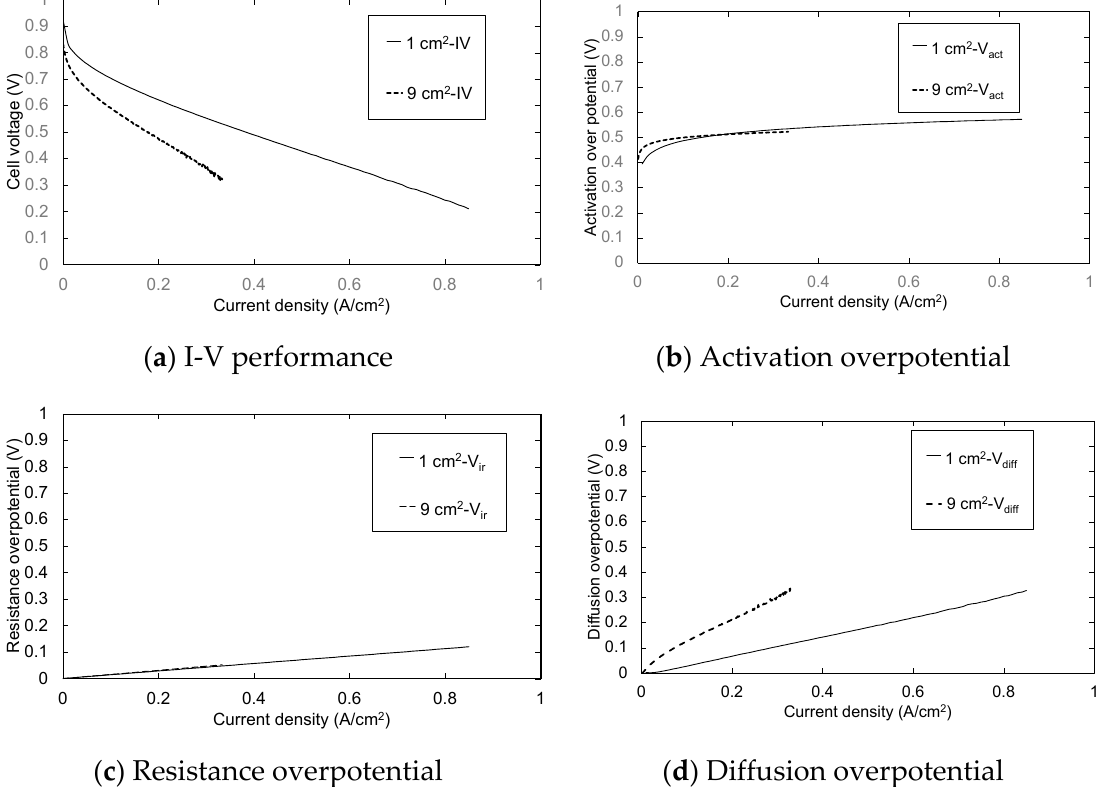
Figure 9. Influence of the electrode area on ( a ) I-V performance, ( b ) activation overpotential, ( c ) resistance overpotential and ( d ) diffusion overpotential.